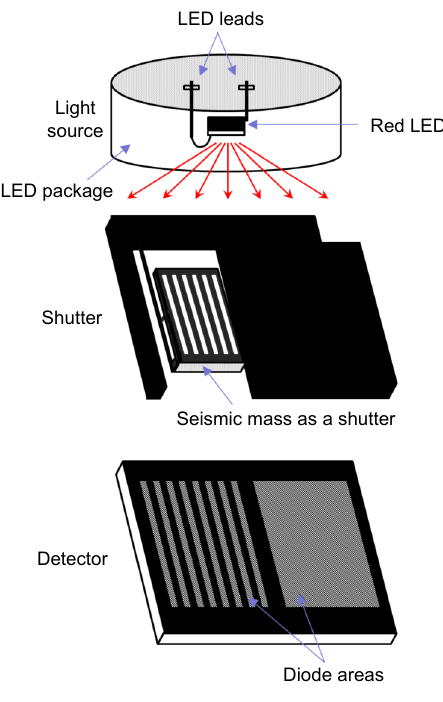
Fig. 3 | Structure of a MOEMS accelerometer based on light in- tensity. Figure reproduced with permission from ref. 8 , IEEE.